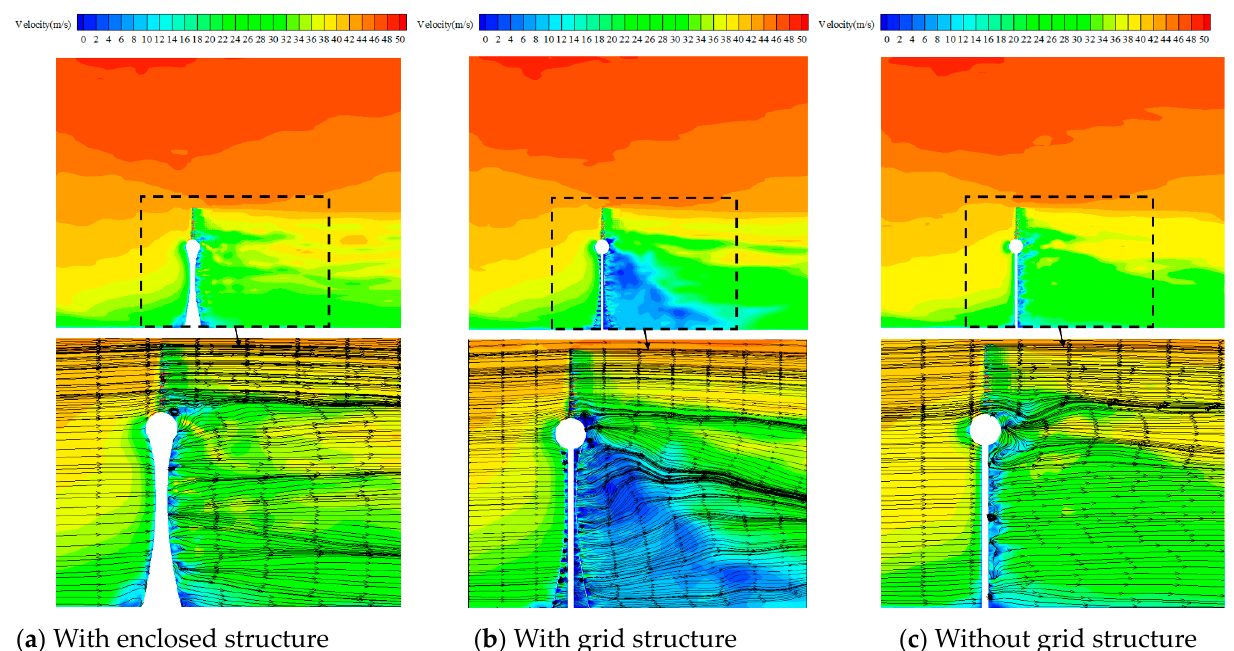
Figure 20. Instantaneous wind speed contours and streamlines of the three models at 20 s in the plane of Y = 200 m.